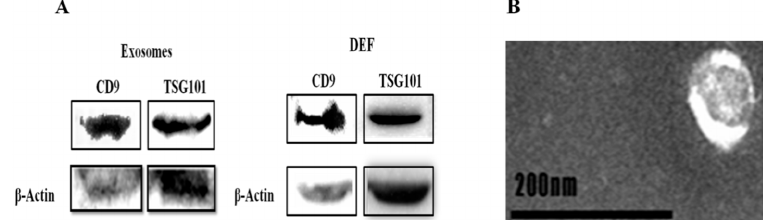
Figure 12. Morphological characterization and identification of exosomes. Exosomes were purified from serum-free medium of DEF cells, exosome protein markers (CD9 and TSG101) were identified by Western blot analysis. β -actin was used as an internal control. ( A ) their morphological features were observed by electron microscopy. Exosomes were nanometer-sized microvesicles (20–120 nm) ( B ).